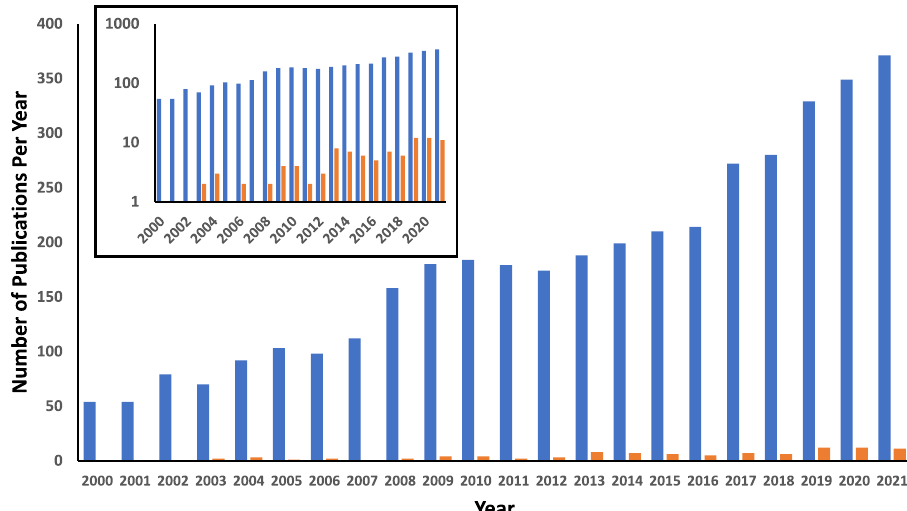
Fig. 3 Number of biomedically-relevant journal articles published on hydrogel swelling since 2000 (blue bars) compared to the number of those same papers that mention PBS (orange bars). Inset: The same data presented on a logarithmic scale to enable easier visualization. Source of data: Web of Science. See Supplementary Information for details of the method used to conduct the